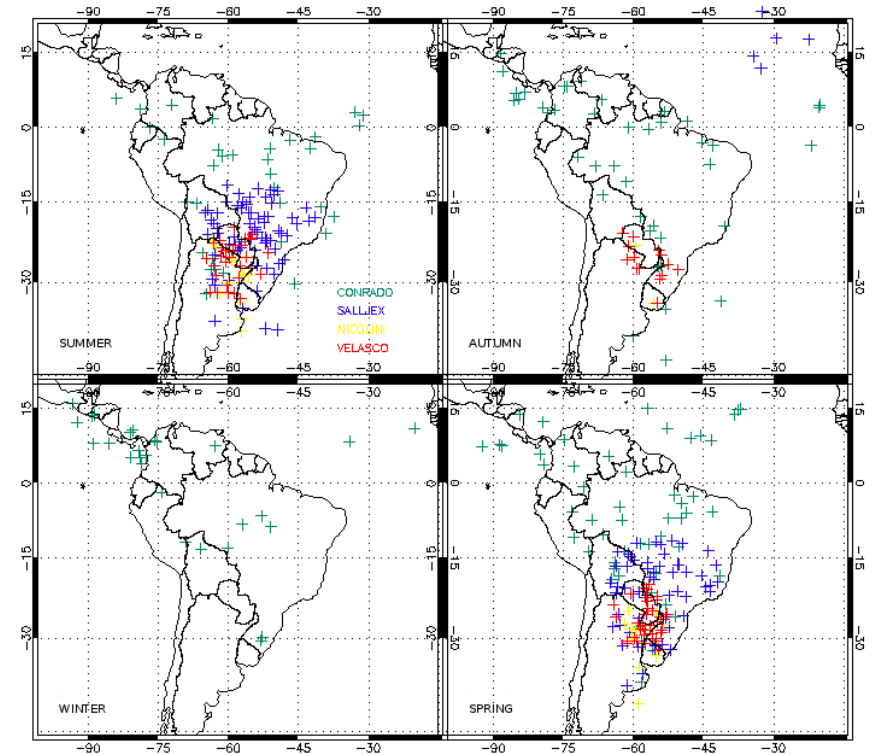
Fig. 1. Climatological distribution of MCS over South America for each season (Silva Dias et al., 2009). The figure is a compilation of results from Velasco and Fritsch (1987), Conforte (1997), Torres and Nicolini (2002), and Salio et al. (2007). The MCS observed during SALLJEX (Vera et al., 2006) are